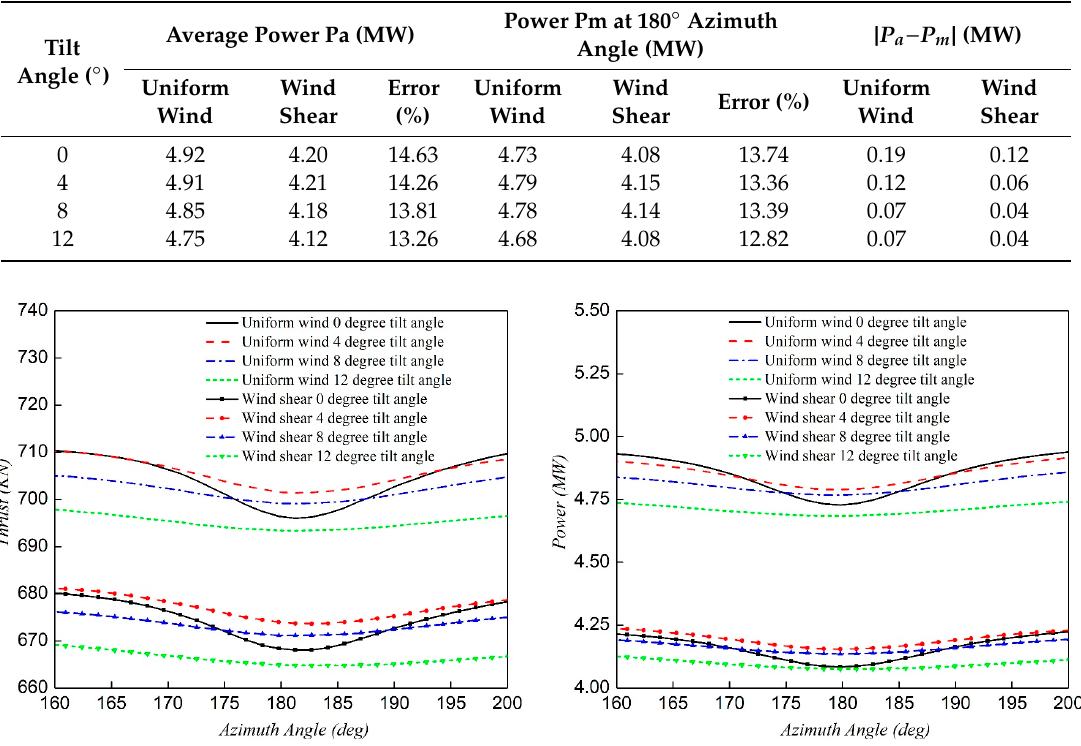
Figure 23. Thrust and power versus azimuth angle for various tilt angles at V hub = 11.4 m / s ( γ = 0.2, I ref = 0.14).